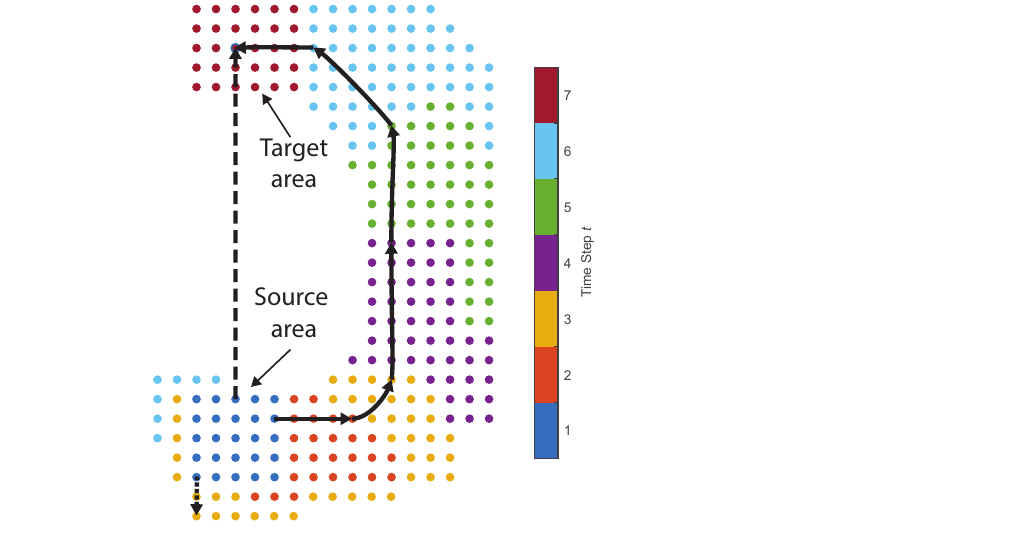
Figure 4. 2D schematic of the routing algorithm. The solid black arrow is the reconstructed flow connection from the blue source area ( t = 1) to the red/blue point in the red target area ( t = 7). The dashed arrow depicts the direct connection. Smaller dotted arrow: flow from source area to a different target point. Different colors indicate different time steps t